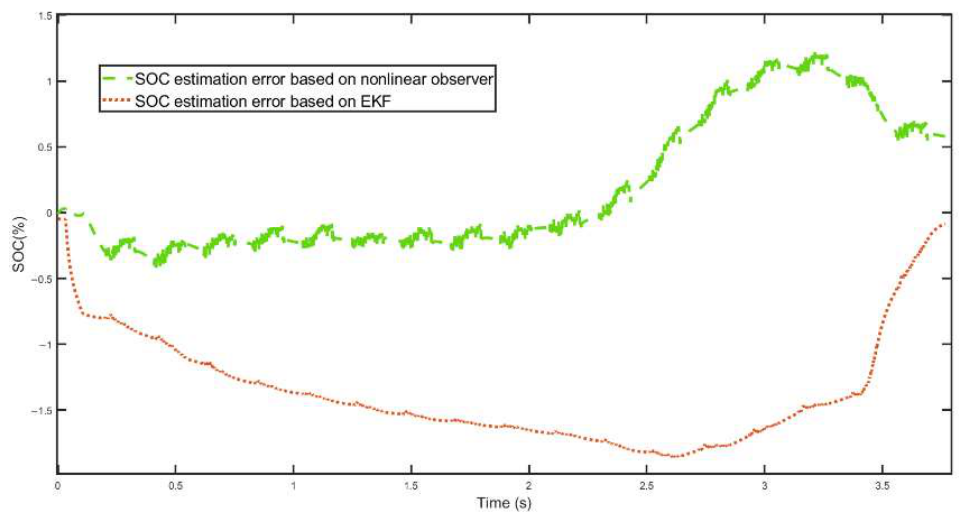
Figure 12. Comparison of SOC estimation error based on non-linear observer and EKF in dynamic condition test 1. condition test 1.